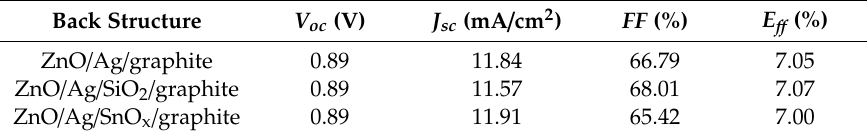
Figure 6. The current density depends on the back structure of the solar cell. Table 2. Electrical efficiency of the solar cell.